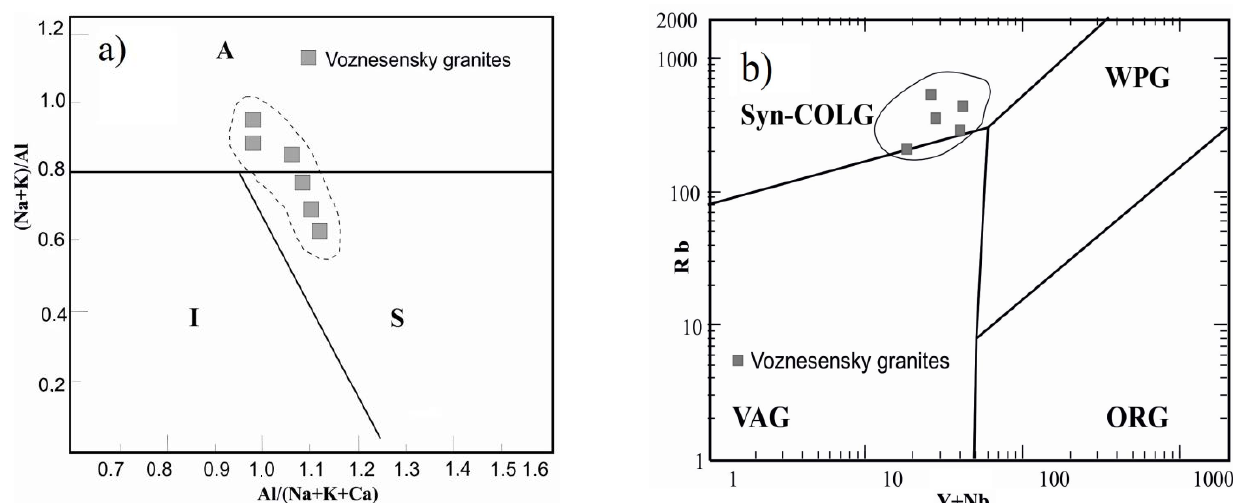
Figure 2. Discrimination diagrams for the Voznesensky complex granites: ( a ) typification of igneous rocks by the ratio of alkalis and alumina; ( b ) (Rb vs. Y + Nb); field boundaries from Pearce [21].